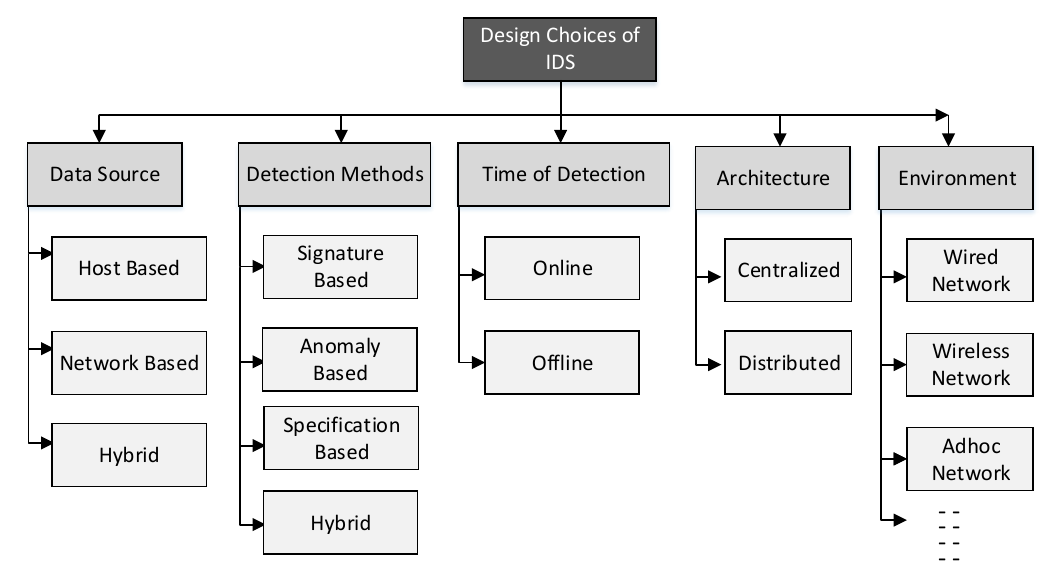
Figure 9. Taxonomy of design choices of IDS for IoT